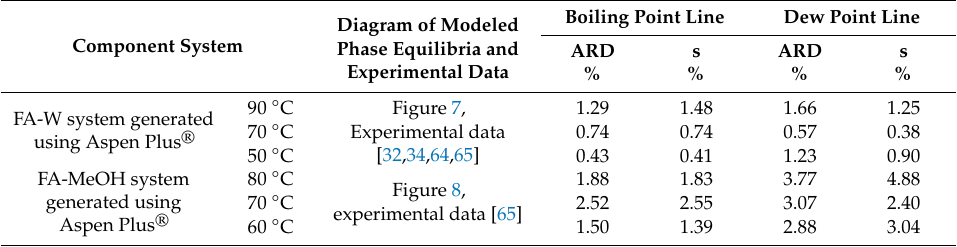
Table 3. Average of the relative deviations and the standard deviations between the modeled phase equilibria diagram shown in Figures 7 and 8, as well as the experimental